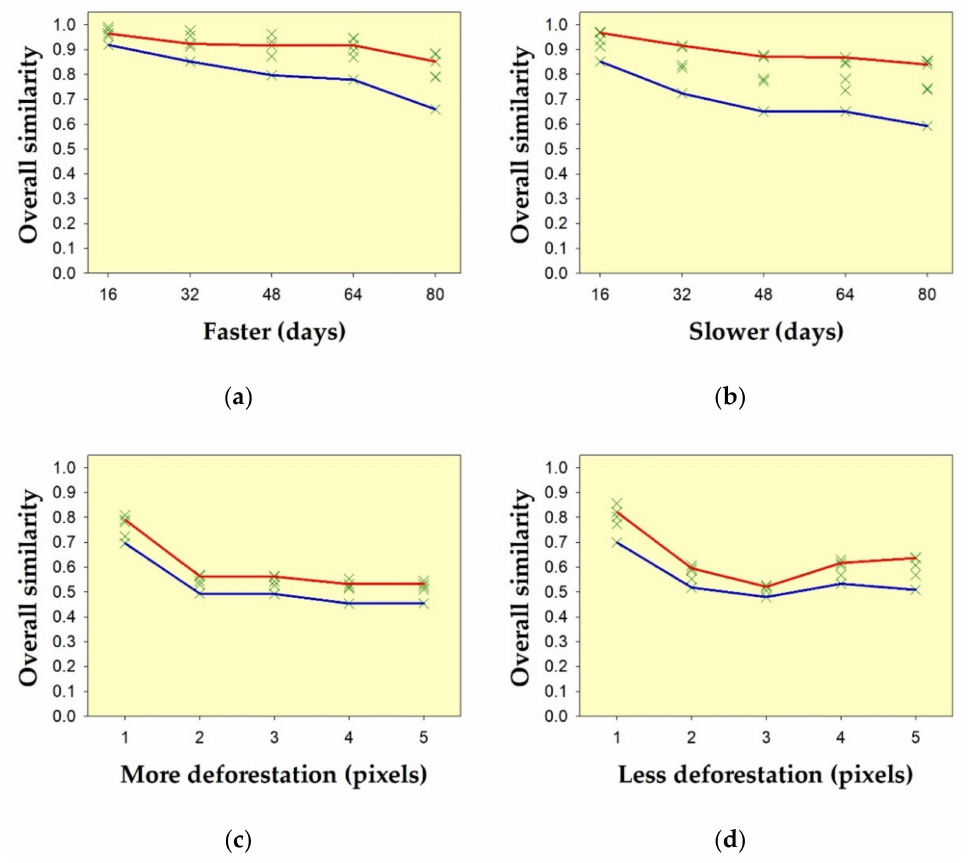
Figure 15. Sensitivity of the method on hypothetical temporal deforestation data sets, due to: ( a ) acceleration; ( b ) delay; ( c ) overestimation; and ( d ) underestimation of deforestation detection, compared to the reference. Green crosses indicate overall similarity (i.e., the average of similarity of θ and similarity of δ ) from all nine metrics. Red lines on the upper edge of the envelopes indicate the overall similarity using the Fidelity metric. Blue lines on the lower edge of the envelopes indicate the overall similarity using the metric of Soergel–Ruzicka–Tanimoto.